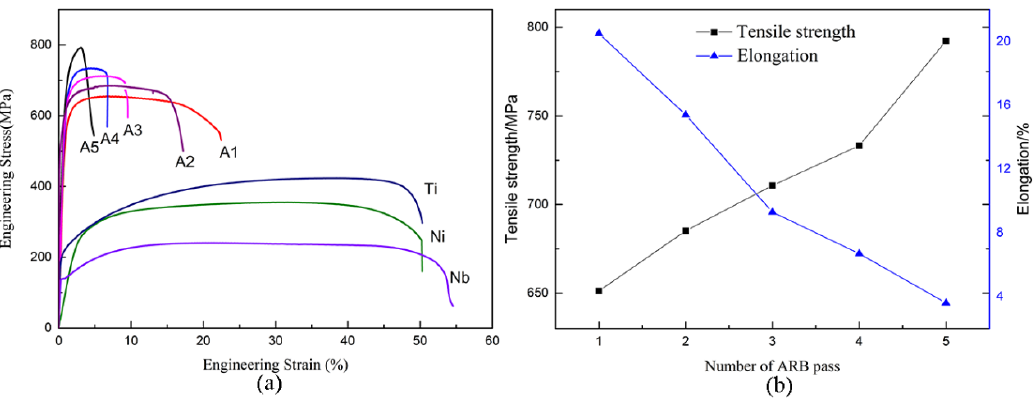
Figure 6. Mechanical properties of the Ni / Ti / Nb multilayer composite: ( a ) stress-strain curves, ( b ) variations of tensile strength and elongation versus the number of accumulative roll bonding (ARB) passes.